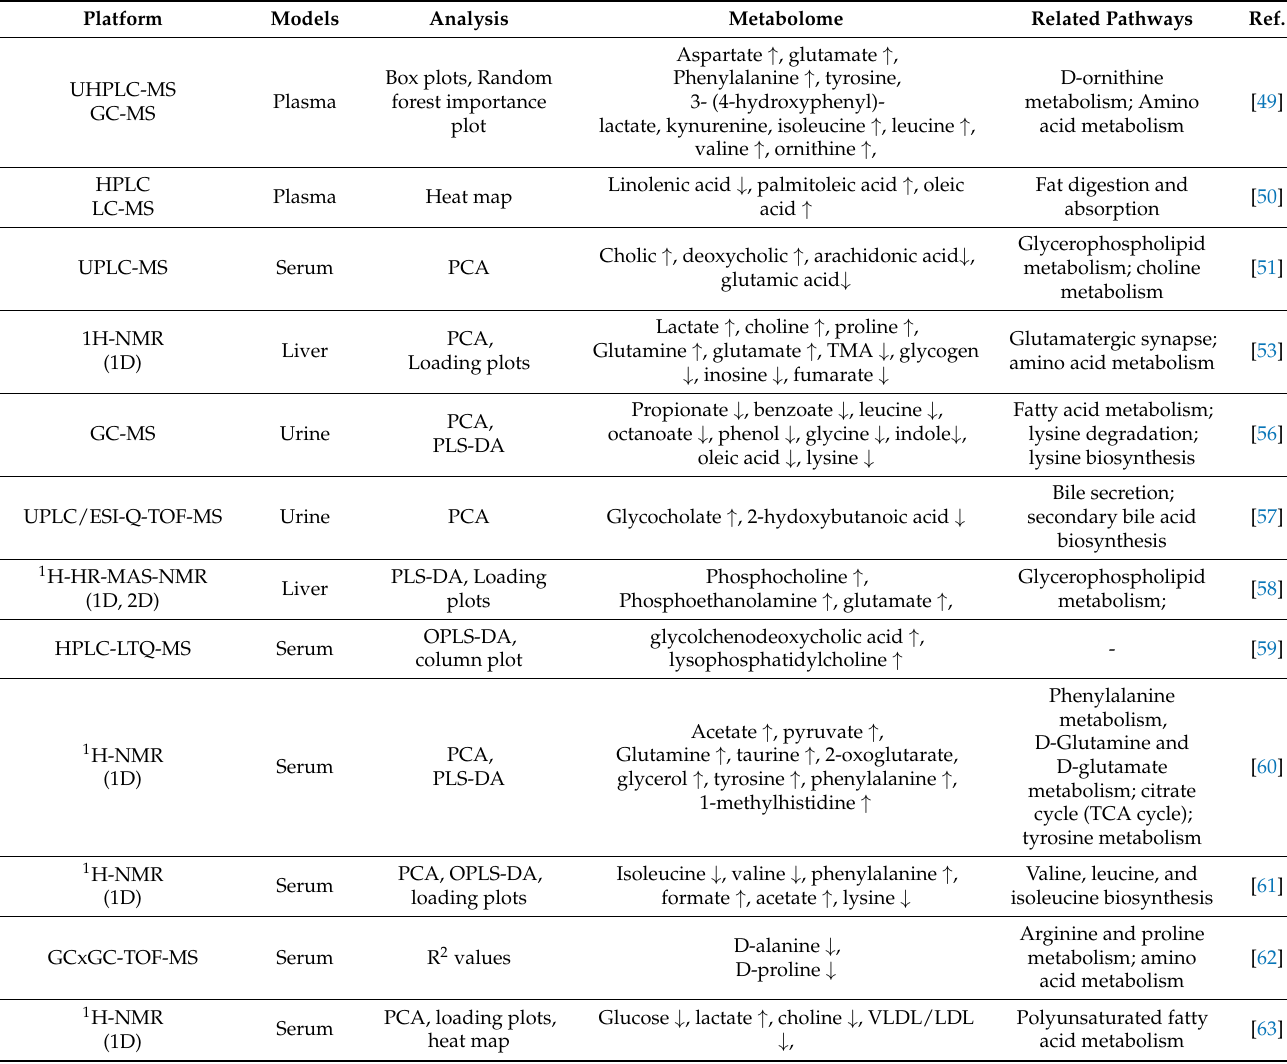
Table 3. Metabolome and metabolomics profiling with hepatic